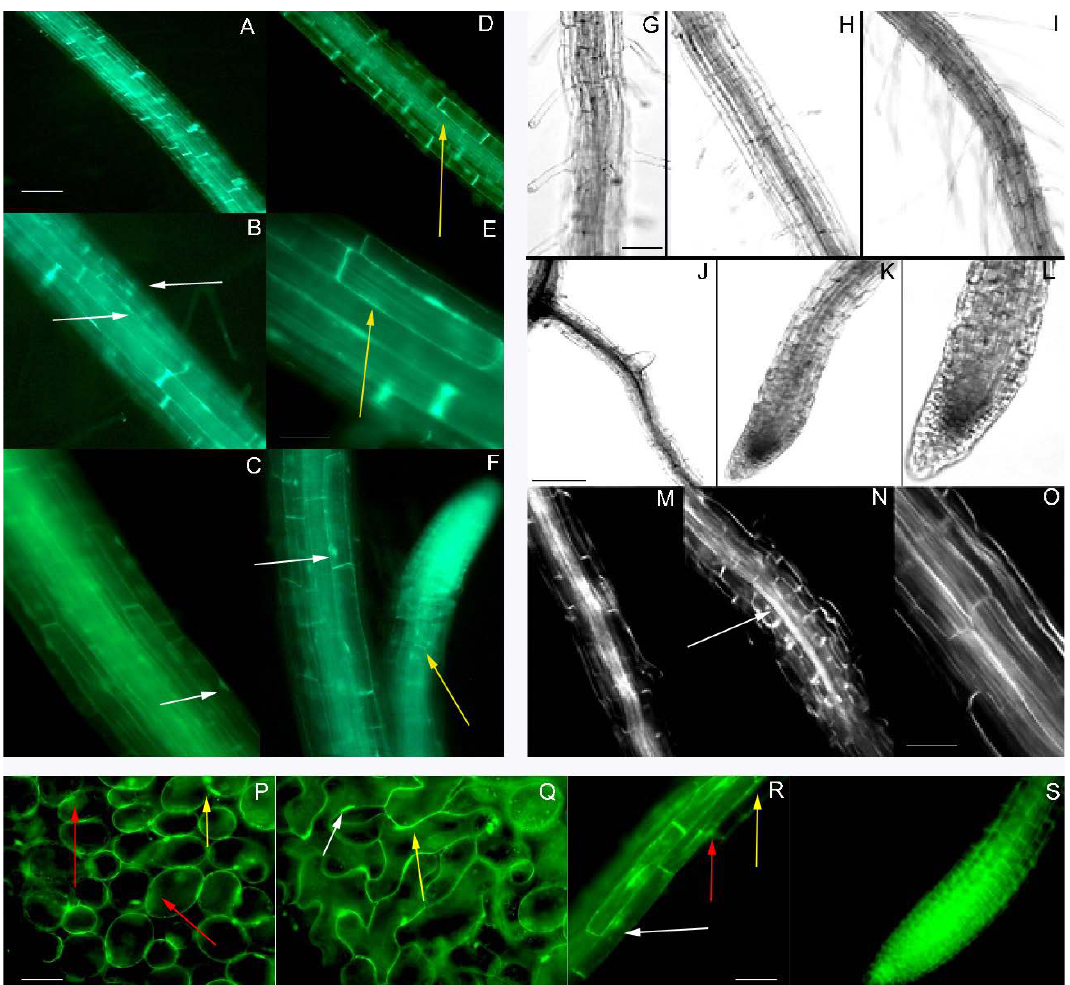
Figure 5. Root and leaf morphology in Arabidopsis OE lines and WT plants. ( A–C ) Roots from Arabidopsis OE lines 4 and ( D – F ) 8 showing green GFP fluorescence in the cell walls (yellow arrows), cytoplasm (red arrows) and nuclei (white arrows) of the epidermal root cells. Different regions of the roots from WT plants in bright field ( G – L ) and dark field ( M – O ) microscope modes. Leaf of the same plants of the OE lines ( P ) 4 and ( R ) 8 showing similar pattern between them and ( Q , S ) WT plants. Bars = 100 µ m ( J ); 50 µ m ( A – D , F – I , K – N , R , S ); 20 µ m ( E , O ) and 10 µ m ( P , Q